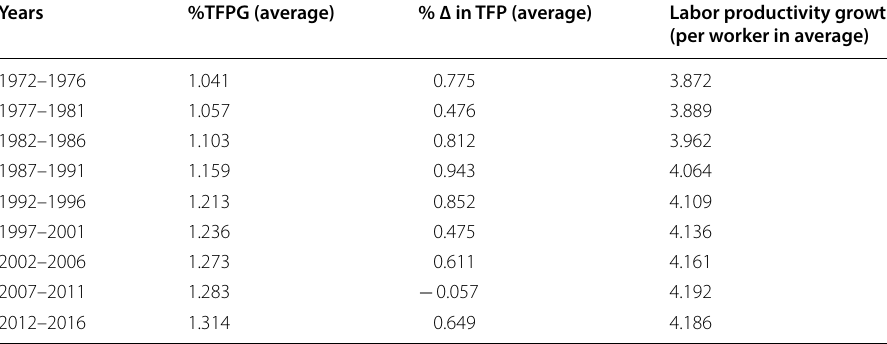
However, the productivity (along the lines of the Solow–Swan (neoclassical) model; see, Barro and Sala-i-Martin 2004): where growth rate of output as ∆ Y / Y